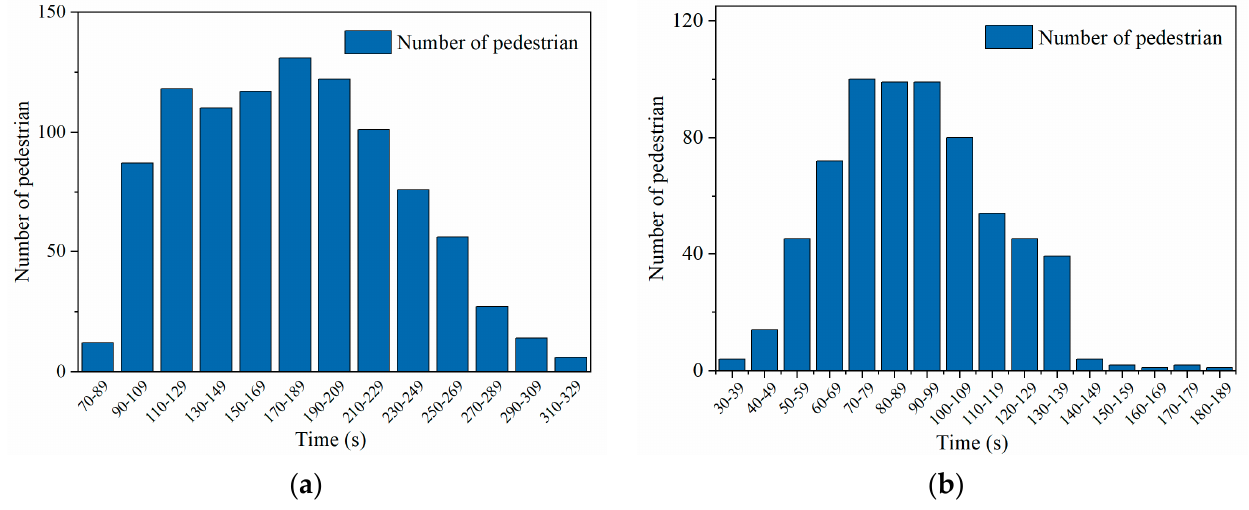
Figure 25. Residence time distribution of boarding and alighting pedestrians: ( a ) Boarding; ( b ) Alighting. For the PM2.5 exposure value, the relative error between the calculated value